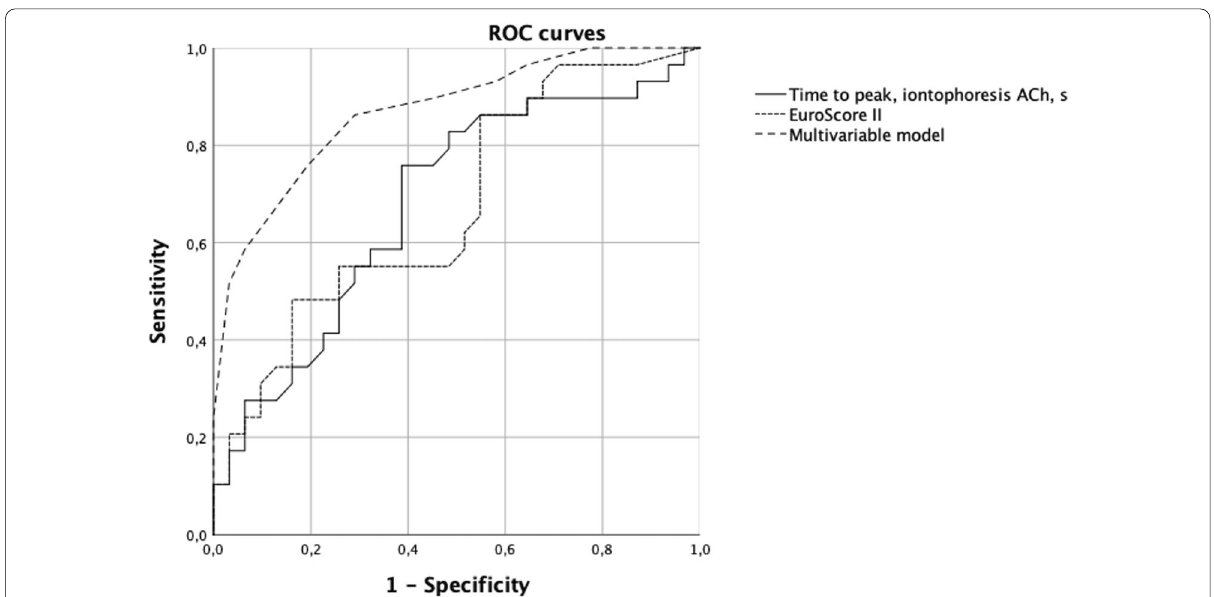
Results of iontophoresis are presented with medians [interquartile range]. Presented data have been filtered by subtraction of movement artifact. P values were obtained for patients with and without an event, using the Mann–Whitney U test Italic value indicates a P value < 0.05